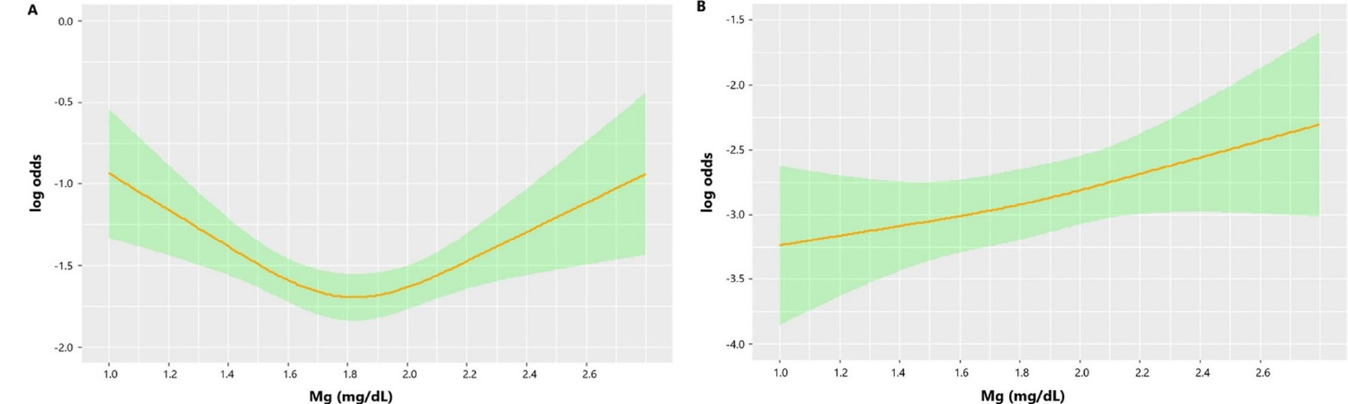
Figure 5. ( A ) Unadjusted association between serum magnesium level and risk of mortality. ( B ) Ad- justed association between serum magnesium level and risk of mortality. Adjusted for age, diabetes, chronic heart diease, diastolic blood pressure, ISS, GCS, WBC, platelet, RBC, RDW, hemoglobin, glucose, blood urea nitrogen, serum creatinine, RBC transfusion, platelet transfusion, coagulopa- Table 2. Univariate logistic regression analysis of risk factors for coagulopathy in TBI patients. thy,